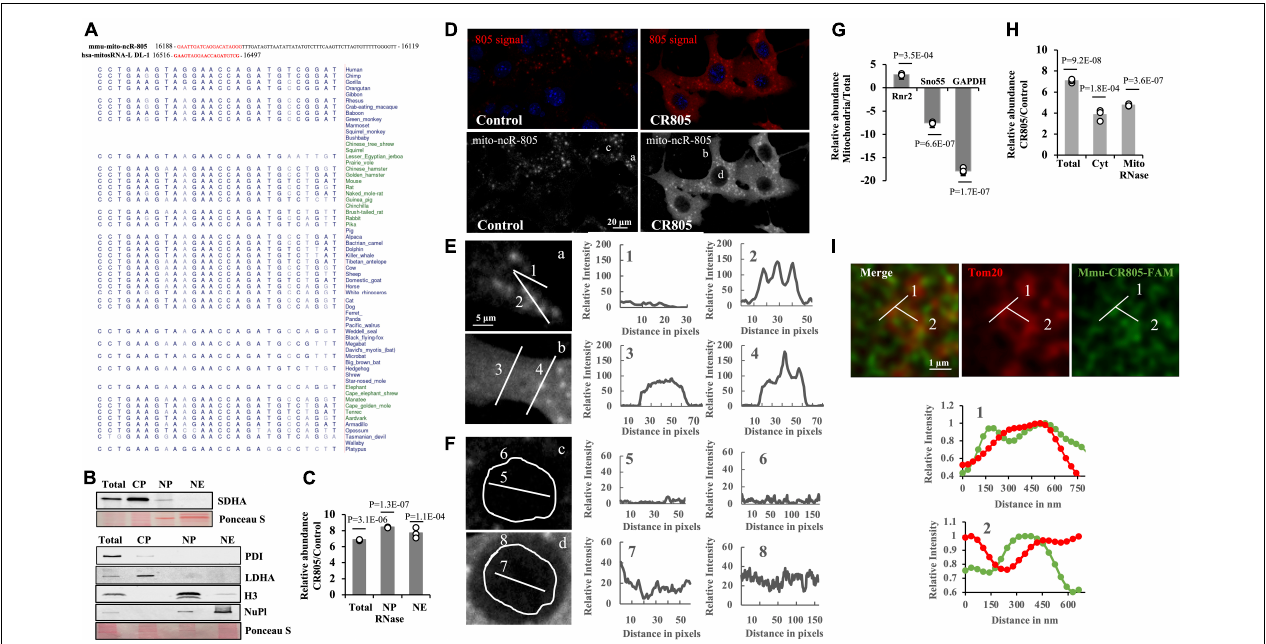
FIGURE 1 | The first 20 nt of mito-ncR-805 is evolutionarily conserved in the mammals. (A) Alignment of mmu-mito-ncR-805 (accession number MI0005204) and hsa-mito-RNA-L-DL-1, which maps to the D-loop of the control region (Ro et al., 2013). Multiz alignment of hsa-mito-RNA-L-DL-1 with sequences from 100 vertebrates. The evolutionarily conserved region is shown in red. (B–H) Subcellular distribution of transfected mmu-CR805 (or control) in MLE12 cells. (B,C) Total, cytoplasmic (CP), nuclear pellet (NP), and nuclear extract (NE) fractions were prepared. NPs were treated with RNase I. (B) Purity of the fractions was assessed by the presence of the cytosolic protein, LDHA, mitochondrial protein SDHA, endoplasmic reticulum protein PDI, nuclear chromatin protein H3, and nucleoplasm protein nucleoplasmin via Western blot analysis. Ponceau S staining is shown as a loading control. (C) Small RNAs were extracted from generated fractions and analyzed for the expression levels of transcripts containing the conserved region of mito-ncR-805 by RT-qPCR. (D) MLE12 cells transfected with control or mmu-CR805 were grown on slides, fixed, and hybridized with a mito-ncR-805-specific probe. Images were acquired at 63 times magnification on a Leica DM IRE2 Leica SP8 laser confocal microscope. (E,F) Enlarged areas from Panel (D) are shown on the left. Graphs on the right show relative red channel fluorescence intensity through the line-scanned regions. (E) Line-scans drawn through cytoplasm (1 and 3) and structures positive for mmu-mito-ncR-805 and/or mmu-CR805 (2 and 4). (F) Line scans drawn through and around the perimeter of nuclei of cells transfected with non-targeting RNA (top image) and mmu-CR805 (bottom image). (G,H) MLE12 cells transfected with mmu-CR805 or non-targeting RNA oligos were lysed and analyzed (total fraction). Cytosolic fractions (Cyt) were obtained by separating the crude mitochondria, which were further purified using Percoll gradient and treated with RNase I to remove non-mitochondrial RNAs. The RNAs were isolated from the obtained fractions. (G) Purity of the fractions was evaluated by comparing the expression levels of mtDNA-encoded mRNA of Rnr2, nucleus-encoded and localized Sno55-RNA, and cytosolic GAPDH mRNA. Graph shows the difference between C T levels relative to the total lysates and with identical RNA inputs. (H) Expression levels of transcripts containing the mmu-CR805 sequence in different fractions as evaluated by RT-qPCR. Graph shows the difference in C T values between the control and mmu-CR805-transfected cells. (I) The MLE12 cells were transfected with FAM-labeled mmu-CR805, fixed, and stained for Tom20. Images were acquired at a magnification of 100 times and zoom of 3.37 times on a Leica TCS SP8 microscope with accelerated deconvolution (entire images are provided in Supplementary Figure 2 ). Line scans were drawn through Tom20-labeled structures. Graphs show relative red and green channel fluorescence intensity through the line-scanned